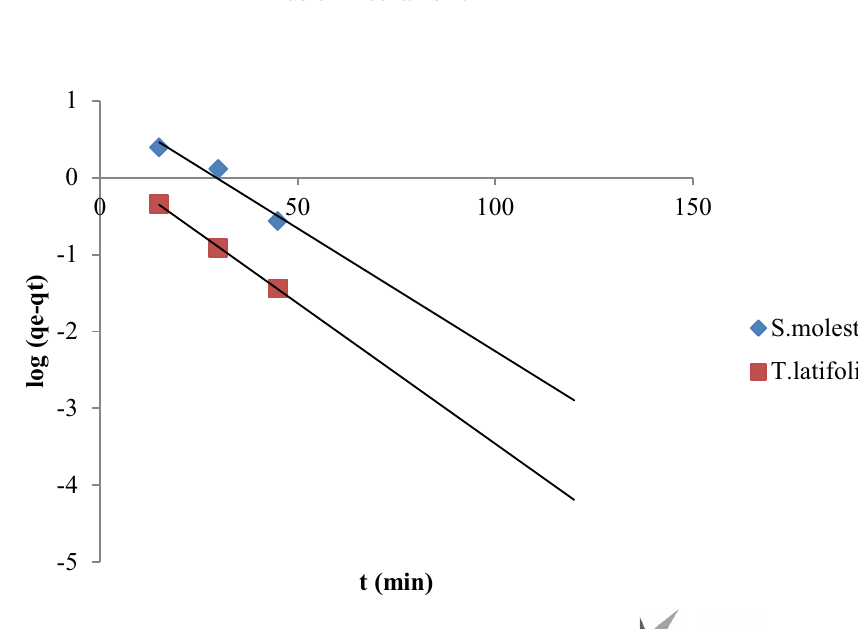
Fig. 13 Pseudo-first-order kinetic plot for Cr 6+ adsorption on S. molesta and T.